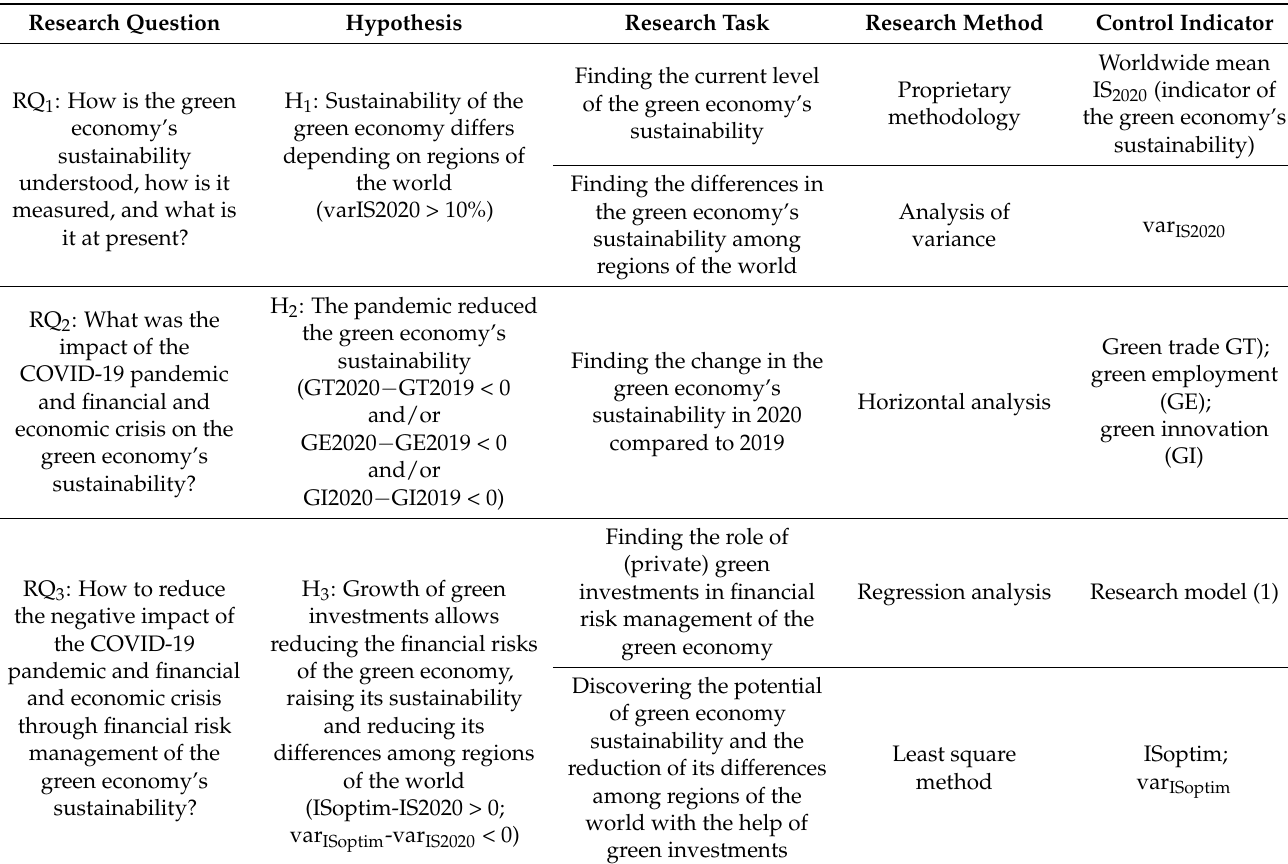
Table 1. The conceptual model of the